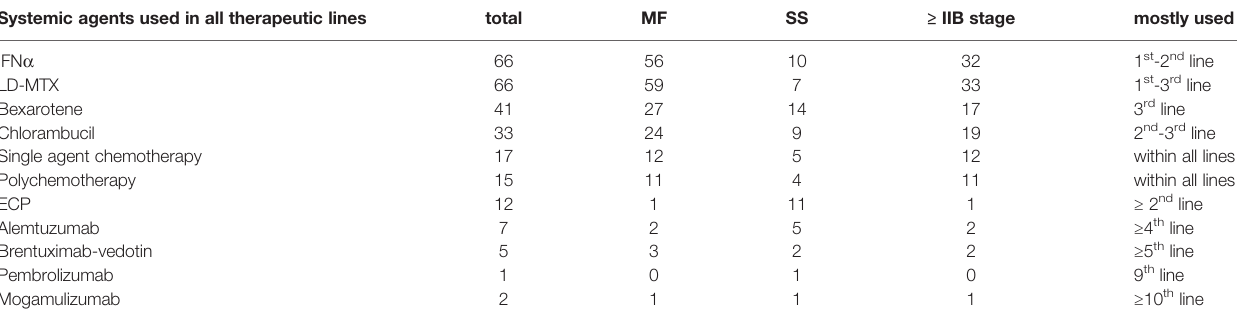
TABLE 3 | Systemic agents used in all treatment lines in whole cohort and numbers of patients treated by them in particular clinical groups. Systemic agents used in all therapeutic lines